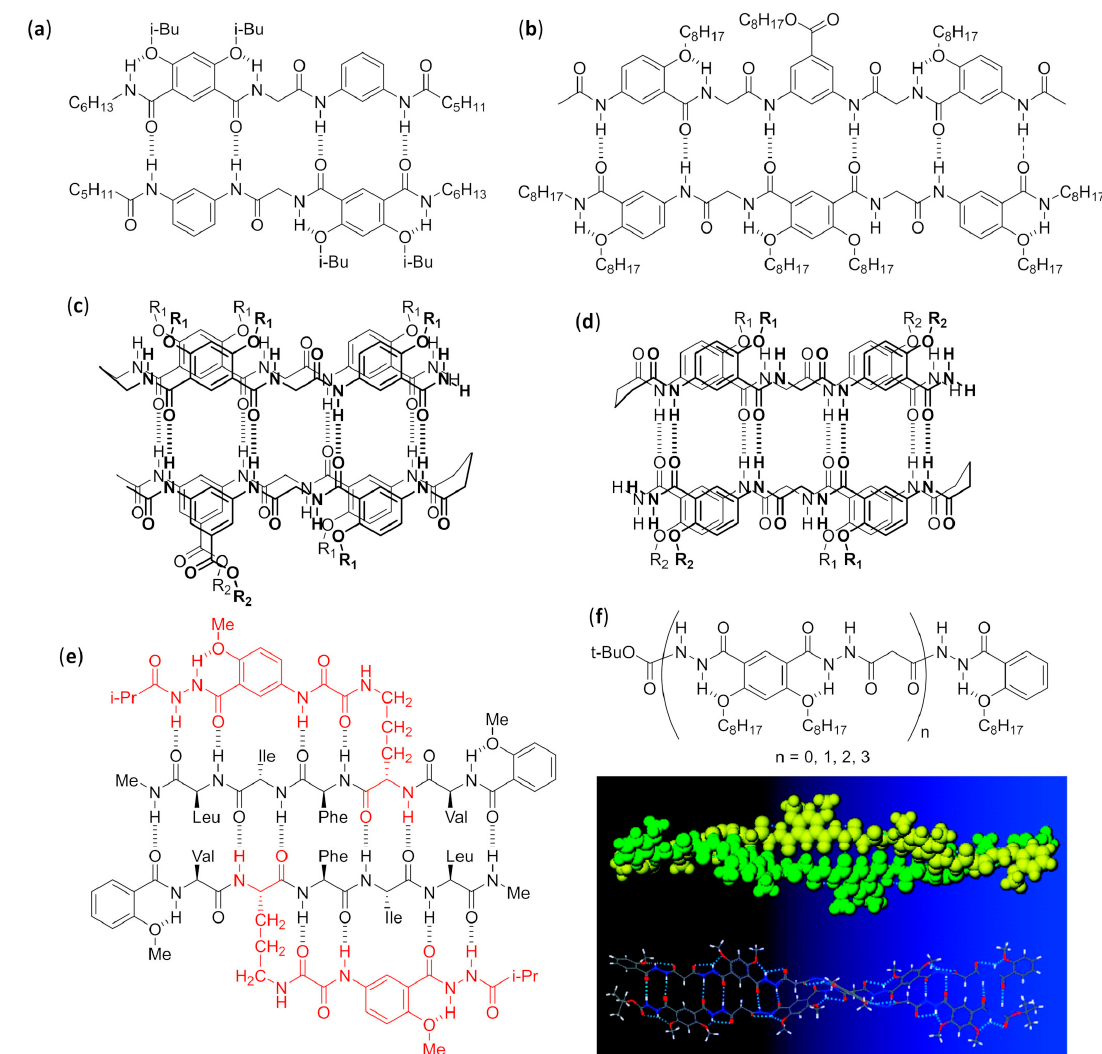
Figure 18. ( a ) Quadruply and ( b ) sixtuply intermolecularly hydrogen bonded dimers (Refs. [196–200]); ( c ) Heteroduplex and ( d ) homoduplex of foldamers whose linear strands are not complementary (Ref. [201]); ( e ) An example of self-recognizing β -sheets based on the Orn( i -PrCO-Hao) sequence, highlighted in red (Refs. [202–205]); ( f ) Flexible aromatic hydrazide-malonic acid alternating foldamers, together with the molecular mechanics-computed structure (n = 3, antiparallel strands are color-coded in the space-filling structure, while those in both intra- and interstrand H-bonds are shown as dotted lines in the stick representation) (adapted with permission from Ref. [206]).